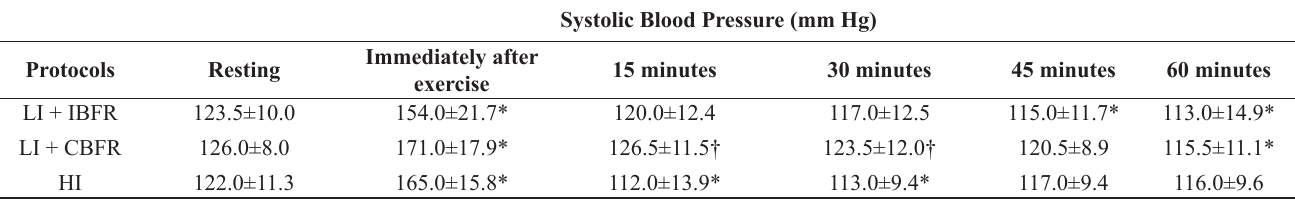
Table 1. Comparative analysis of systolic blood pressure in different study protocols.